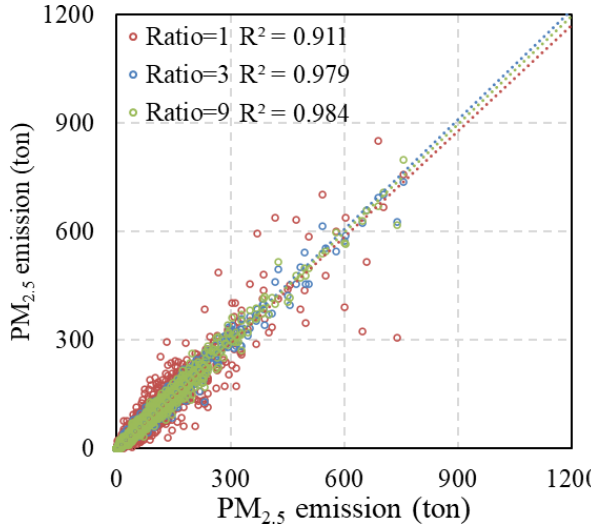
Figure 7. Pairwise relationship between the intersect and sub-grid nearest methods with different sub-grid ratios for particulate matter